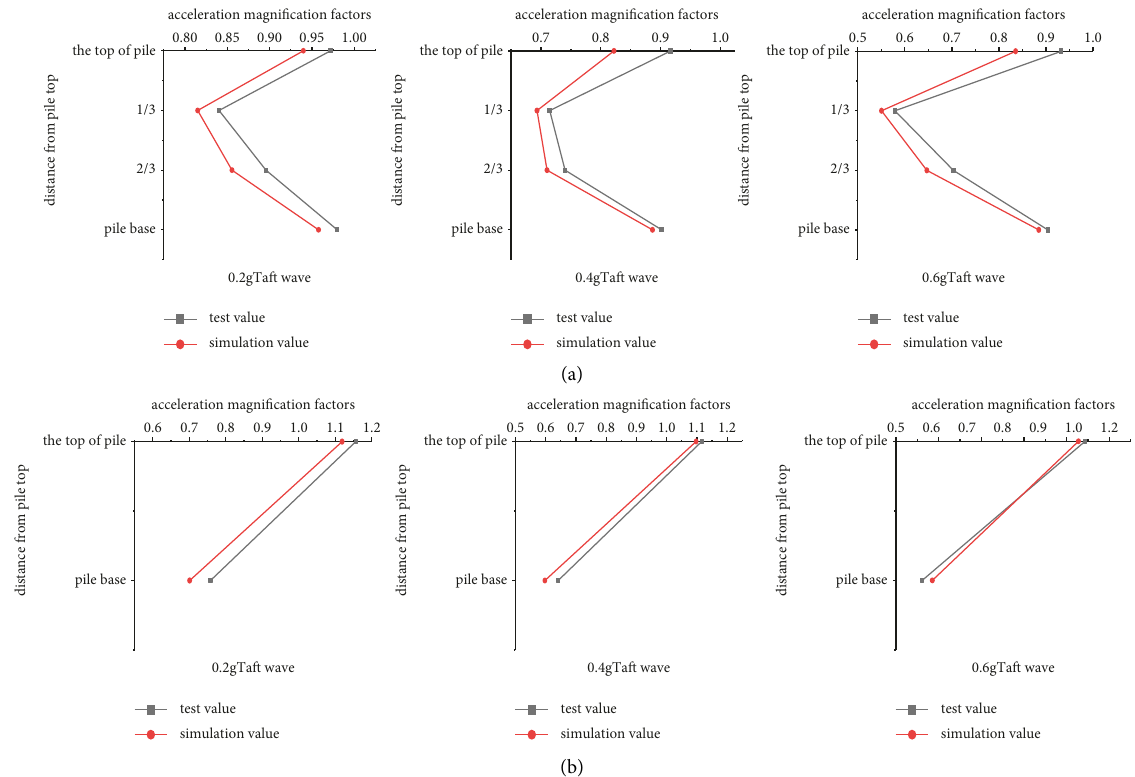
Figure 6: Comparison of test and simulation values of acceleration amplification coefficient of (a) 2 # pile and (b) 3 # pile.